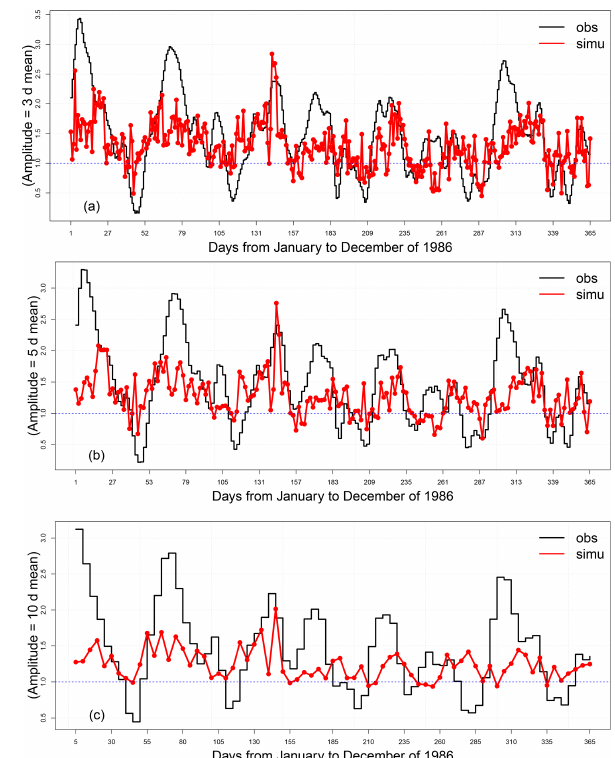
Figure A3. Time series of observations and simulations of the MJO amplitude computed from analogs of OLR for lead times of 3 (a) , 5 (b) , and 10d (c) for the year 1986. The red line represents the mean of the 100 simulations, the black line represents the observa- tions, and the blue line indicates the threshold of the MJO activity A ( t ) > 1.